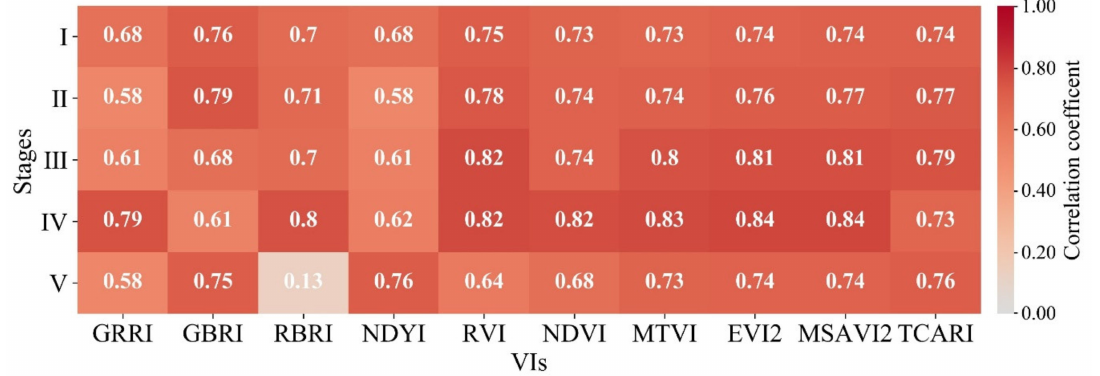
Figure 8. | R | between yield and each of the ten selected VIs for each growth stage of winter wheat at the sampling square scale ( I : jointing stage, II : heading stage, III : flowering stage, IV : filling stage, V : milk-ripe